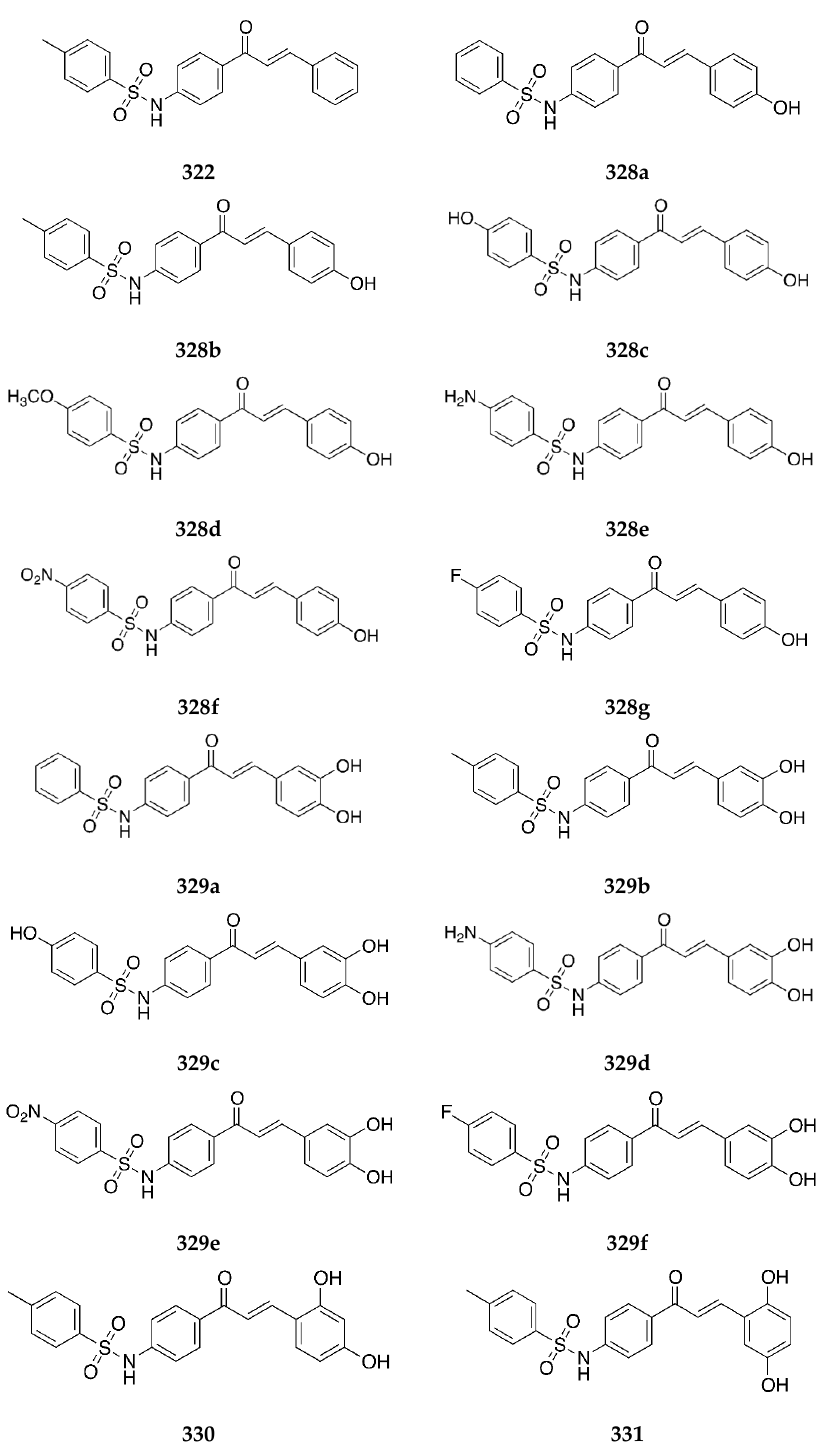
Figure 82. Chemical structure of N -sulfonyl-4-aminochalcone derivatives with substitution on ring B.